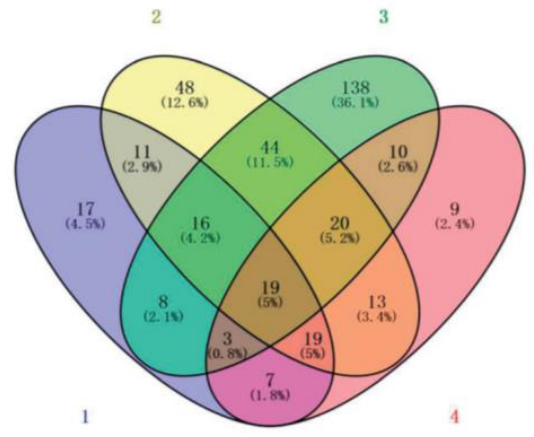
Figure 5. Venn diagram of the number of differentially expressed proteins identified in the bottle gourd proteome under different crossing periods.